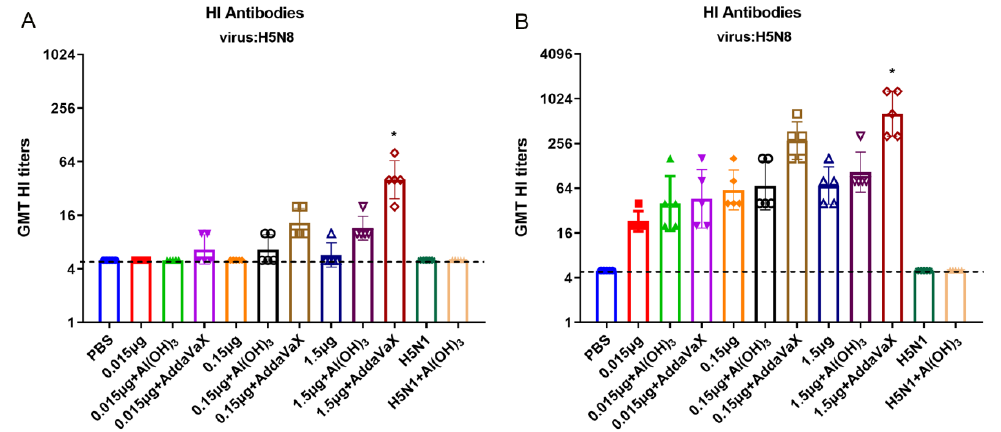
Figure 3. HI titers elicited by H5N8 inactivated vaccine with or without adjuvants. BALB/c mice ( n = 5) were immunized twice with various doses of H5N8 inactivated vaccines with or without adjuvants, or with PBS as a control. ( A ) Serum HI antibodies against H5N8 virus at day 21 post the first immunization were determined by HI assay. ( B ) Serum HI antibodies against H5N8 virus at day 21 post the last immunization were determined by HI assay. Comparing the vaccination effect among various formulations, the asterisk * indicates a significant difference ( p < 0.05) detected by one-way ANOVA.